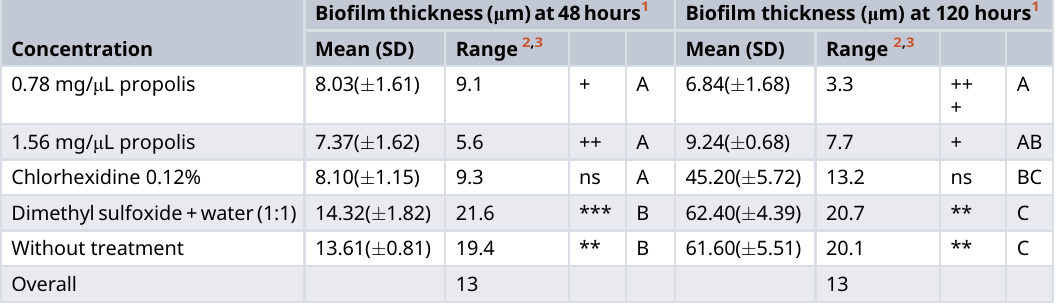
Table6. Effectonbiofilmthickness byconfocalmicroscopyof thepropolisfractionswithantibacterial effects on S. gordonii and F. nucleatum and nontoxicity in the human gingival fibroblast cell line.